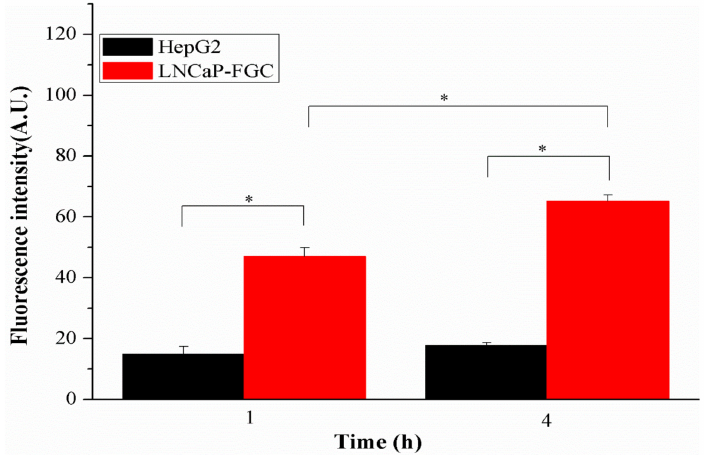
Figure 5. Mean fluorescence intensity of CPT-HT-J-ZL 12 internalized by LNCaP-FGC (high expression of PSMA) and HepG2 (none expression of PSMA) cells after incubation for 1 and 4 h. * p <